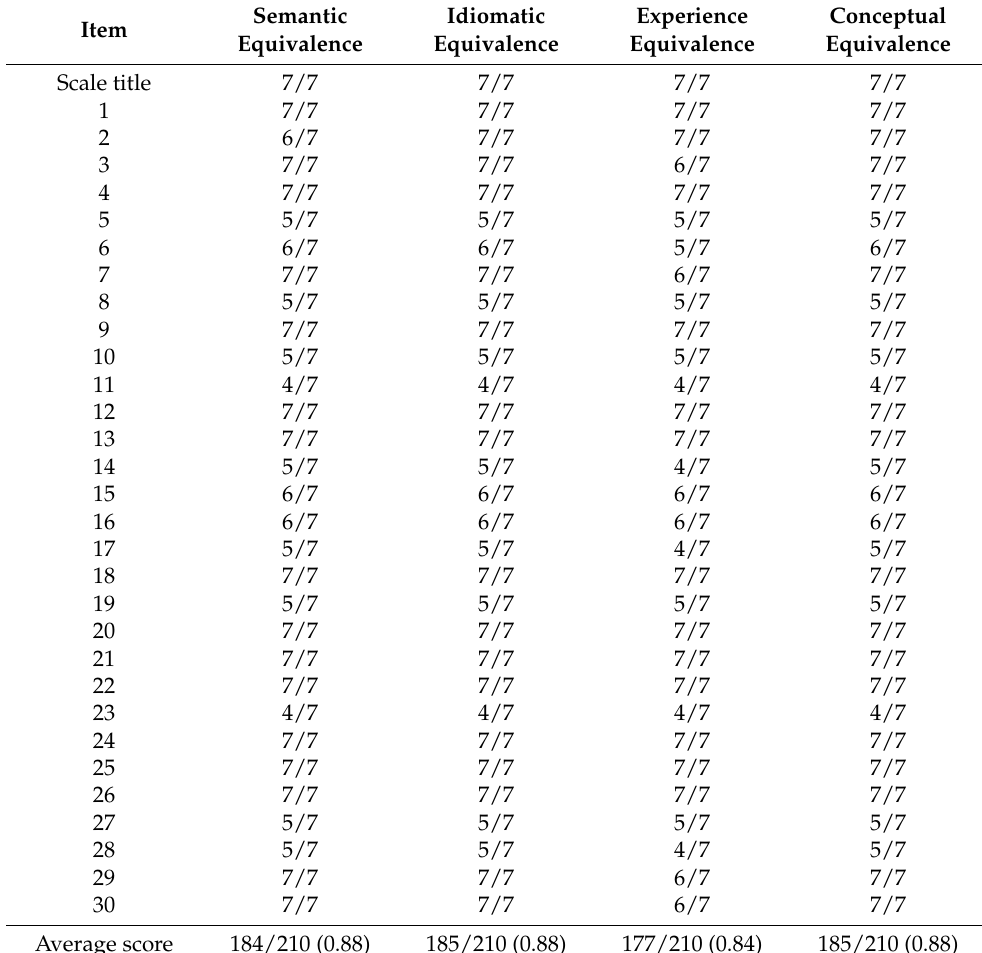
Table 5. Expert committee assessment score for GDS-30 scale.